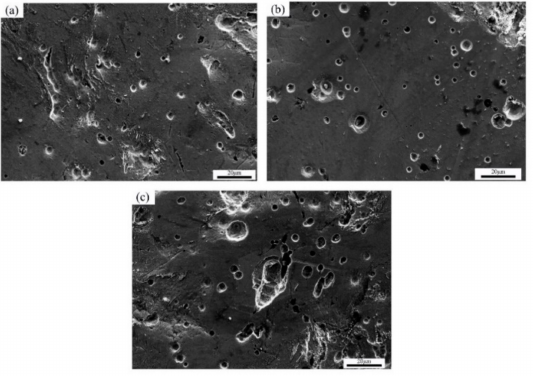
Figure 9. SEM micrographs for the samples RASP-processed for ( a ) 5 min, ( b ) 10 min and ( c )15 min after potentiodynamic polarization in the 0.2 M NaCl + 0.05 M Na 2 SO 4